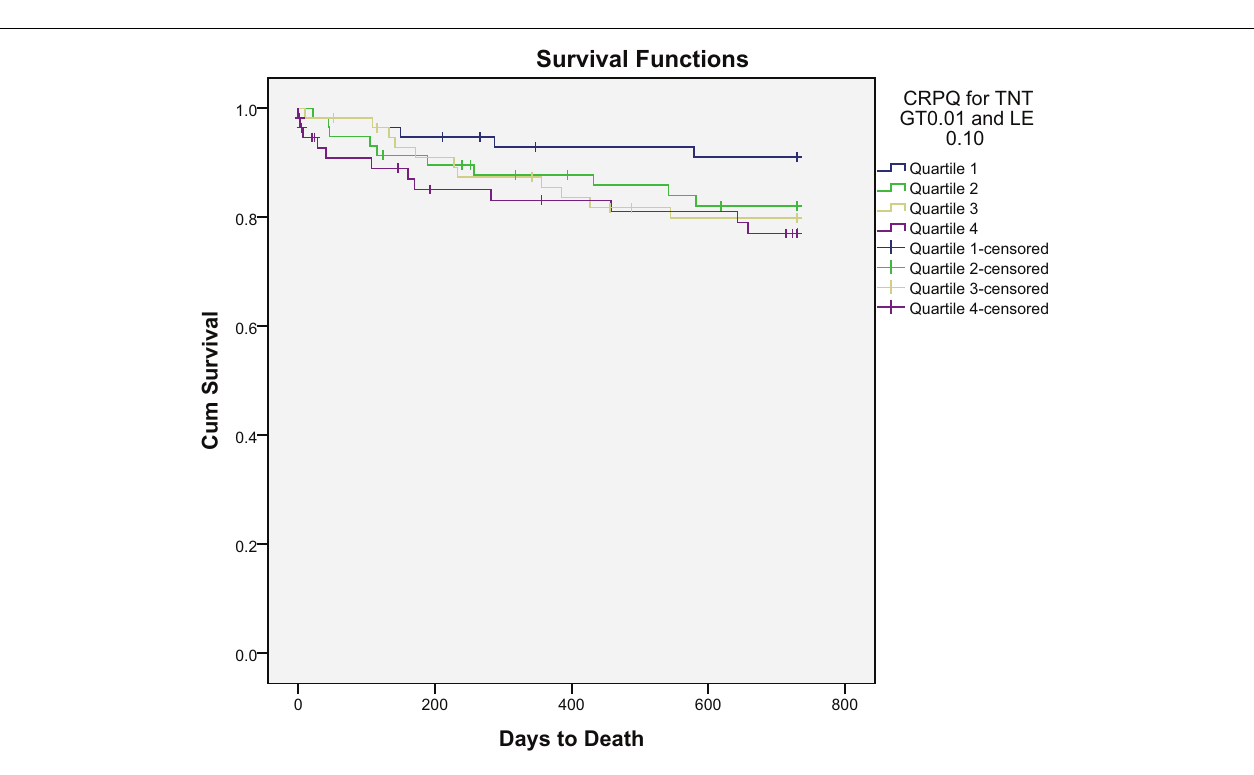
FIGURE 5 | Kaplan–Meier plot of time to cardiac death within 2years by hsCRP quartiles .